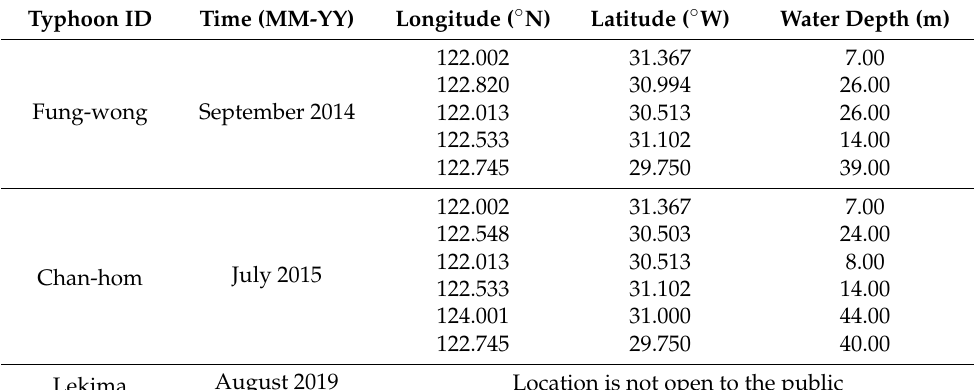
Table 1. The geographic locations of buoys in China Seas used in this study.